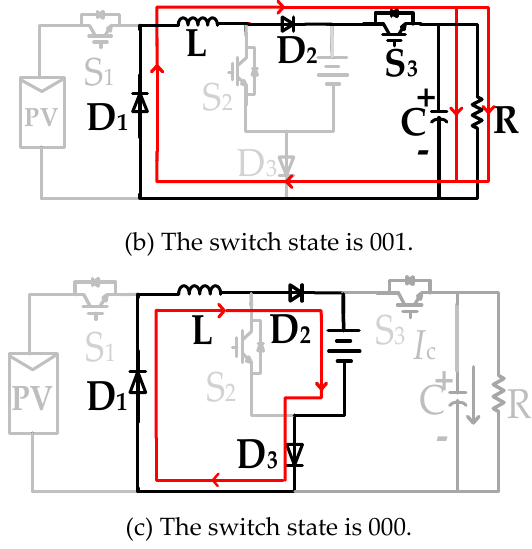
Figure 5. Working states of SIDO mode.